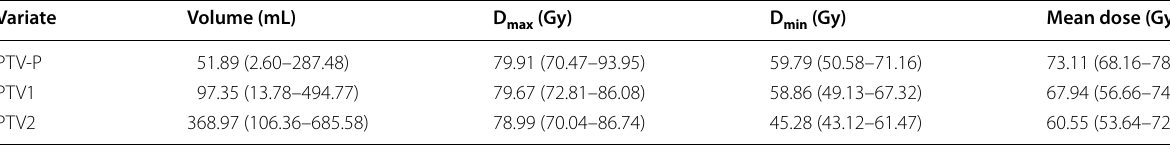
PTV - P planning target volume of the primary tumor, PTV1 PTV of the high-risk clinical target volume, PTV2 PTV of the low-risk clinical target volume, D max maximum dose, D min minimum dose. All data are presented as median with range in